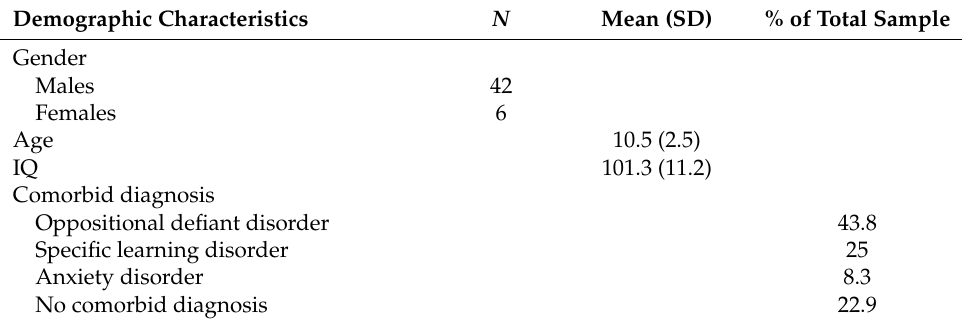
Table 1. Demographic information of participants with